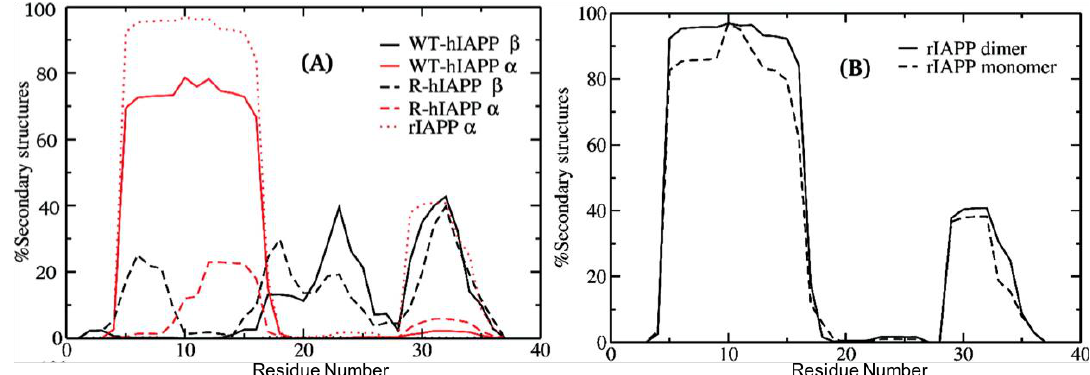
Figure 11. Differences in secondary structure content of monomers and dimers of hIAPP and rIAPP. ( A ) WT-hIAPP and R-hIAPP dimers; ( B ) rIAPP monomer and dimer. Adapted from Laghaei, et al.